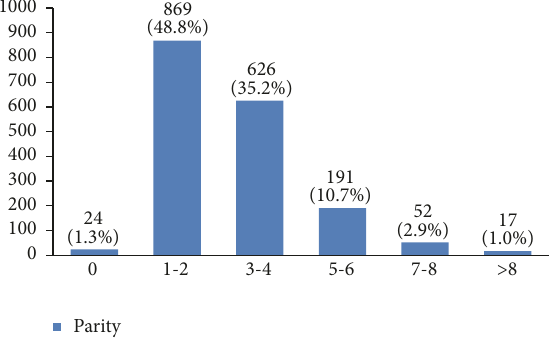
Figure 10: The family history of the studied breast cancer cases.